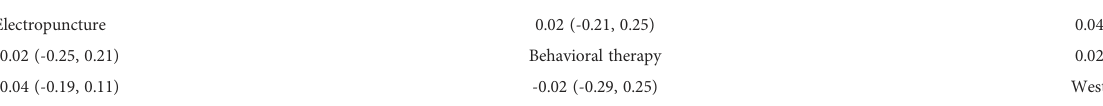
TABLE 11 Network meta-analysis ladder table of